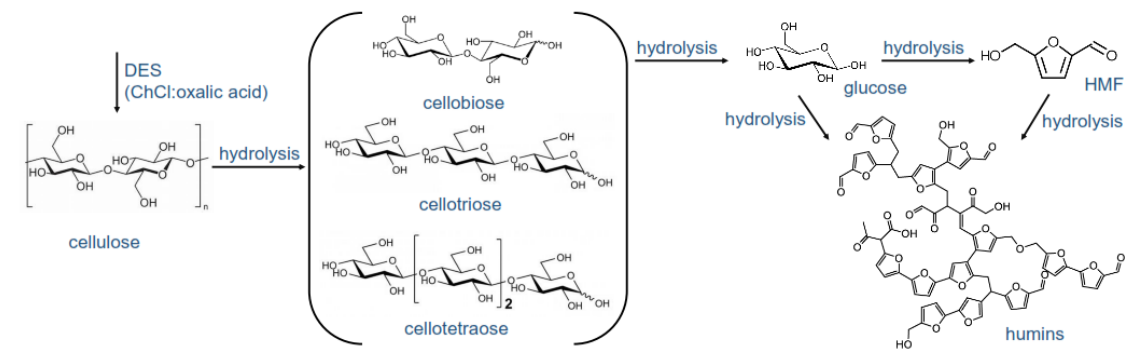
Figure 19. The typical reaction pathway for conversion of cellulosic biomass into value-added chemicals using Brønsted acid-type catalytic DESs.